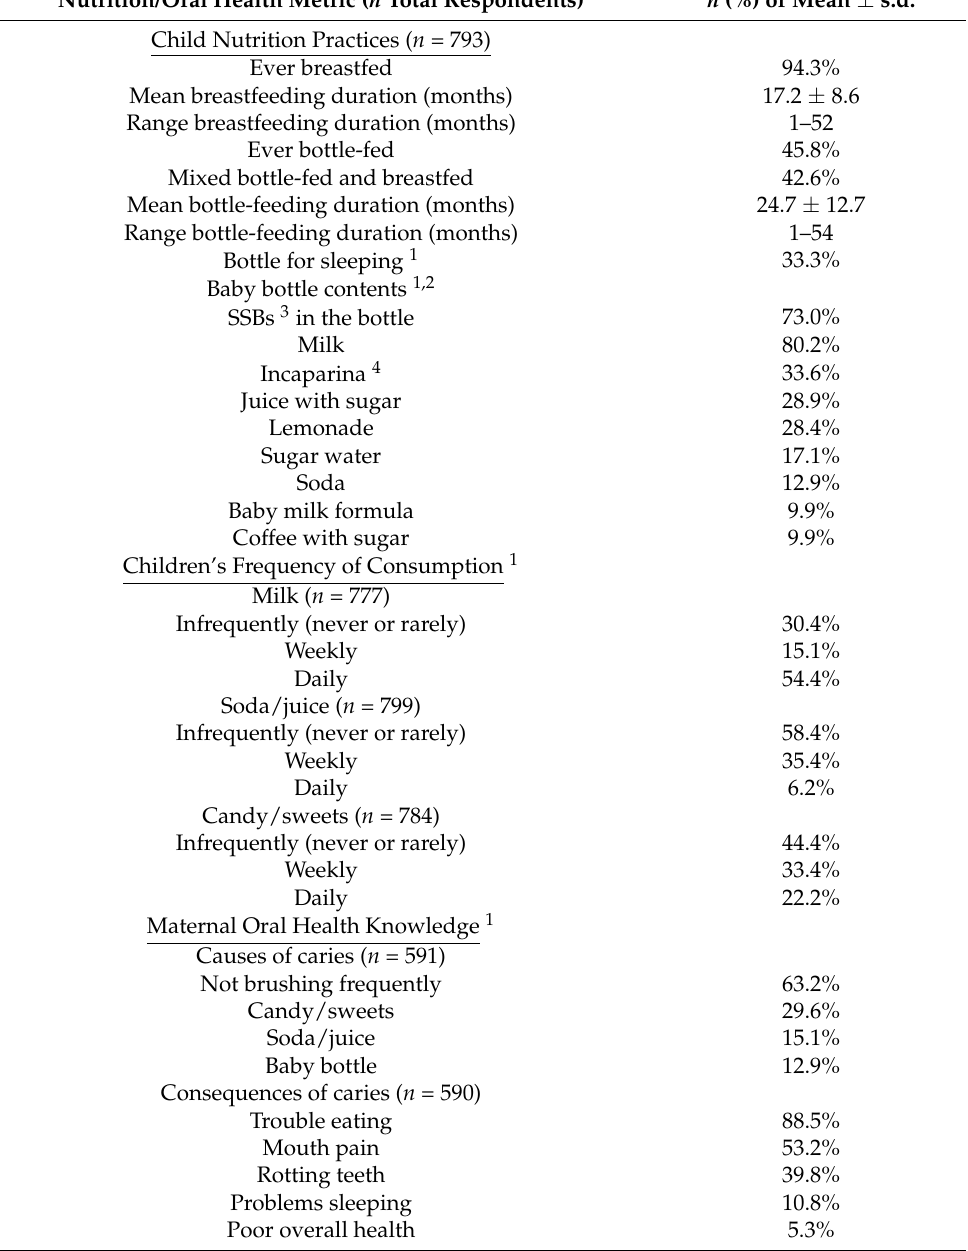
Table 2. Children’s caries-related nutritional practice responses and mothers’ health knowledge and